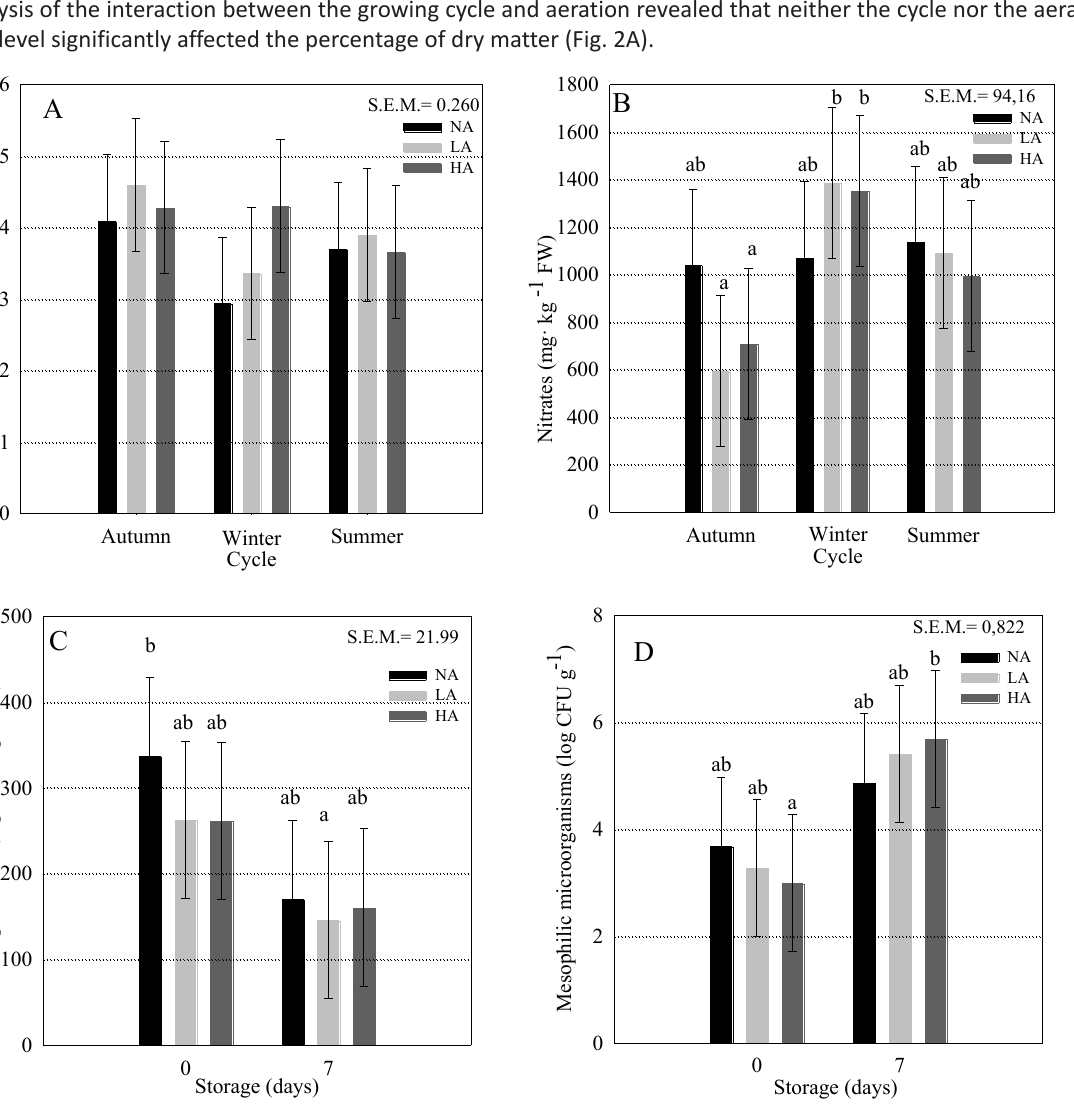
Fig. 2. Effect on % of dry matter (A) and nitrate content (B) of the aeration level of the nutrient solution (no aeration -NA-, low aeration -LA-, high aeration -HA-) in red lettuce cultivated in floating system, in autumn, winter or summer, and the effect on total phenolics (C) and mesophilic microorganism (D) at harvest or after 7 d storage at 5 °C. Vertical lines are the least significant difference (LSD) intervals at p ≤ 0.05. Different letters indicate significant differences ( p < 0.05). A (n=20), B, C and D